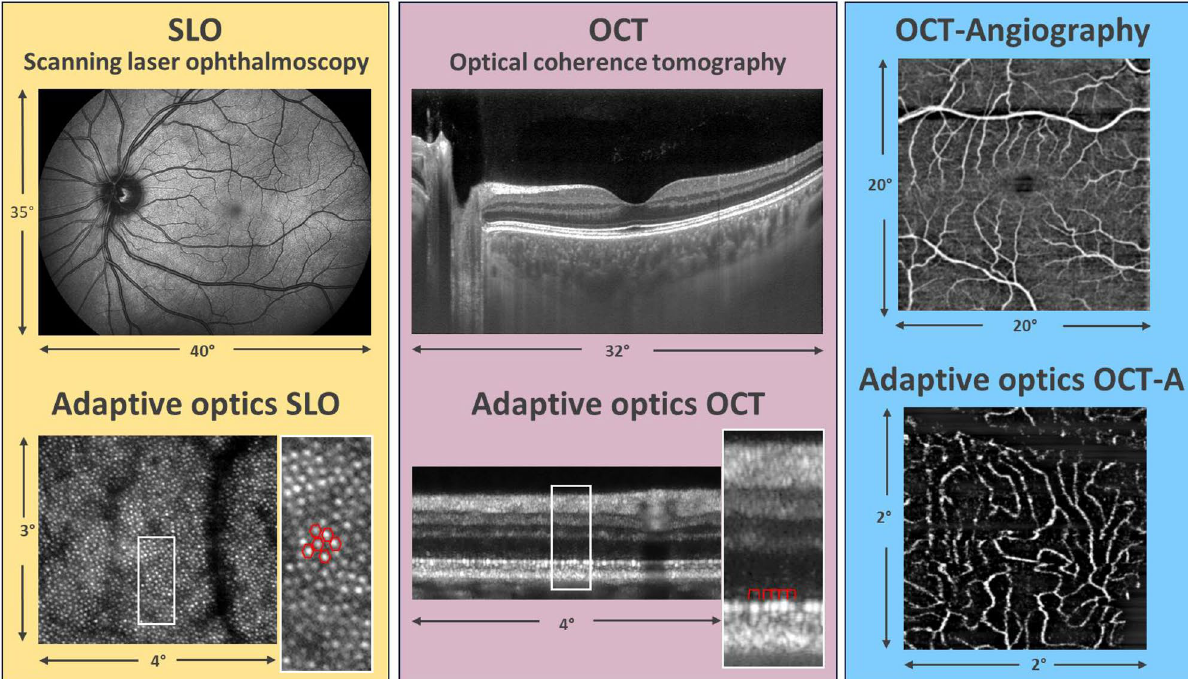
Figure 1. Overview of the multi-modal and multi-scale functionality of the instrument. The signal arising from individual cone photoreceptors is encircled in red